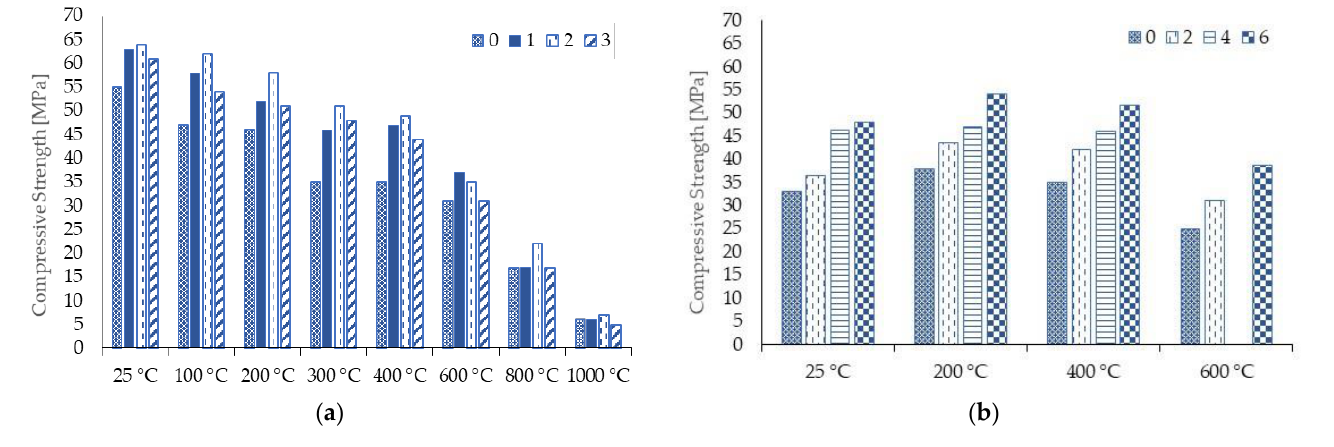
Figure 4. Variation in compressive strength as function of temperature and different percentages of TiO 2 . ( a ) results reported in [86]; ( b ) results reported in [87].